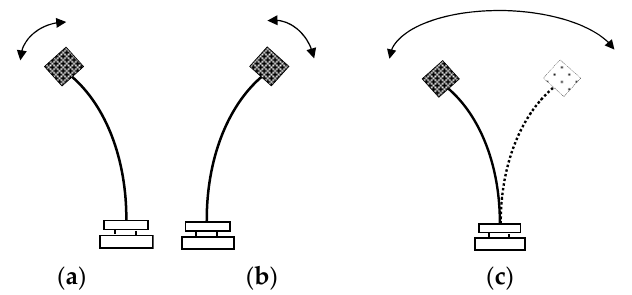
Figure 5. Three vibration states of the bistable vibration model. ( a ) The single stable vibration state on the left. ( b ) The single stable vibration state on the right. ( c ) The bistable vibration state.